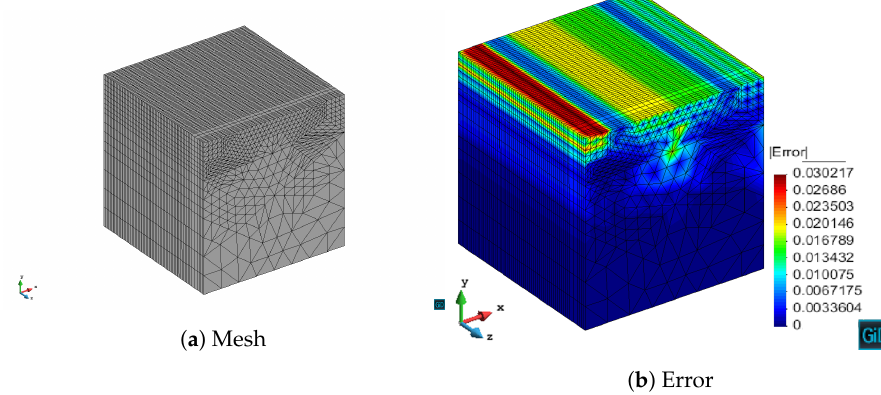
Figure 12. Approximation of (13) using the fixed-energy marking strategy.